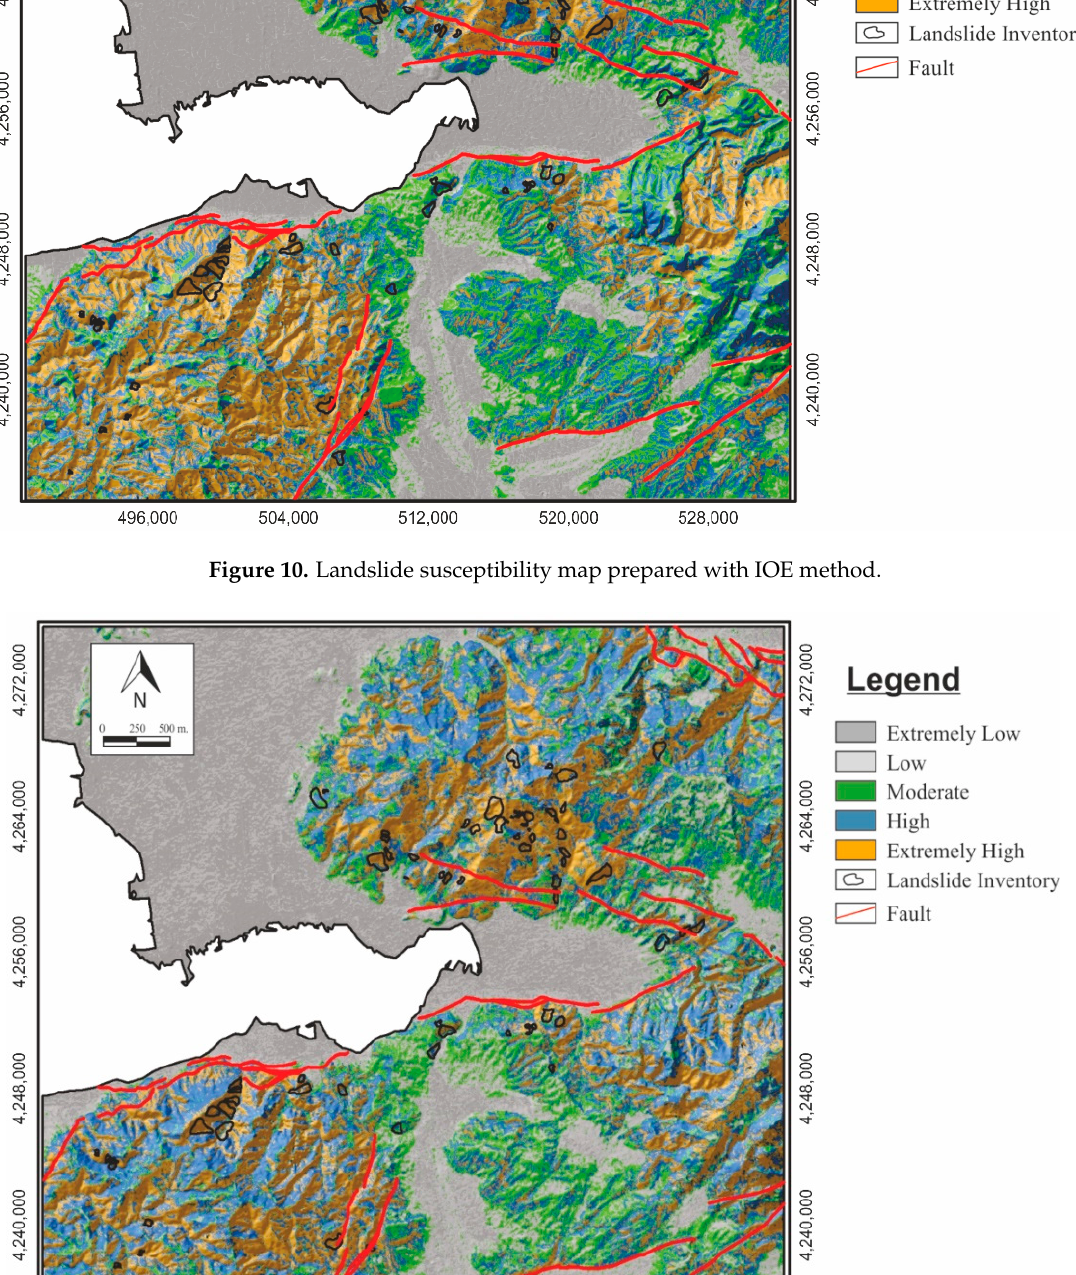
Figure 10. Landslide susceptibility map prepared with IOE method.